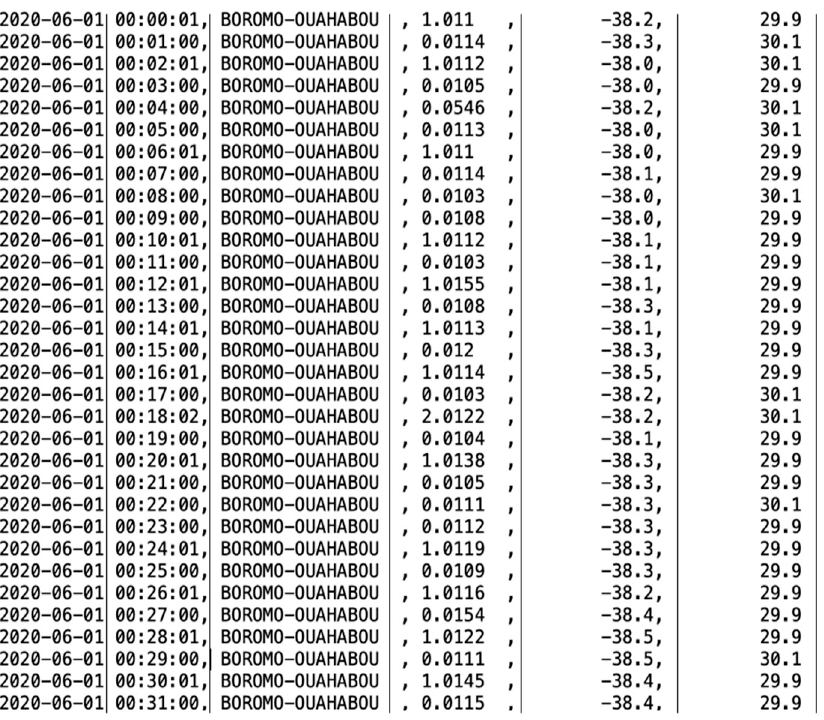
Figure 6. Screenshot of collected data .